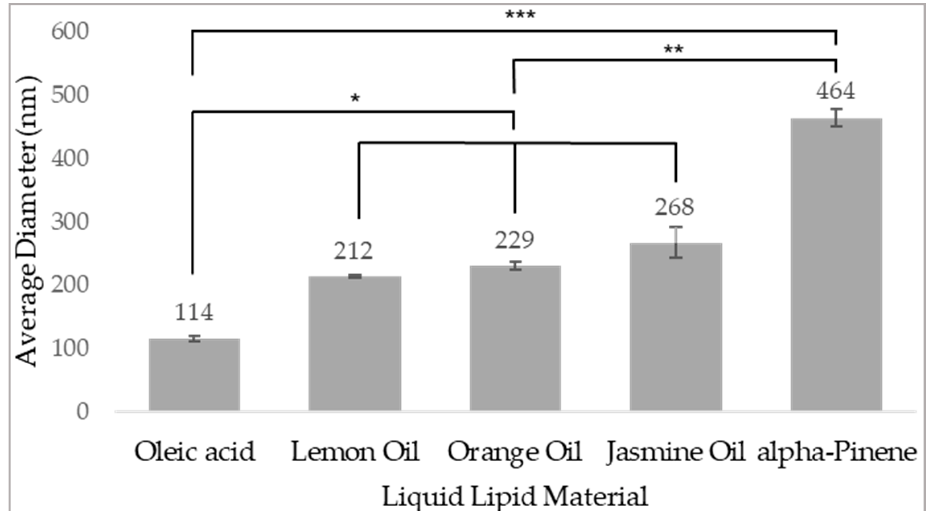
Figure 2. Mean diameter of monomodal distribution of NLCs with various liquid lipids. NLCs formulations of 60% SA-PEG and 40% of different liquid lipids were examined for size distribution. Values presented are means ± SE, n = 2 (two independent experiments each performed in triplicates). Significant differences between liquid lipids are marked as follows: * ( p < 0.0080); ** ( p < 0.0009); *** ( p < 0.0005).